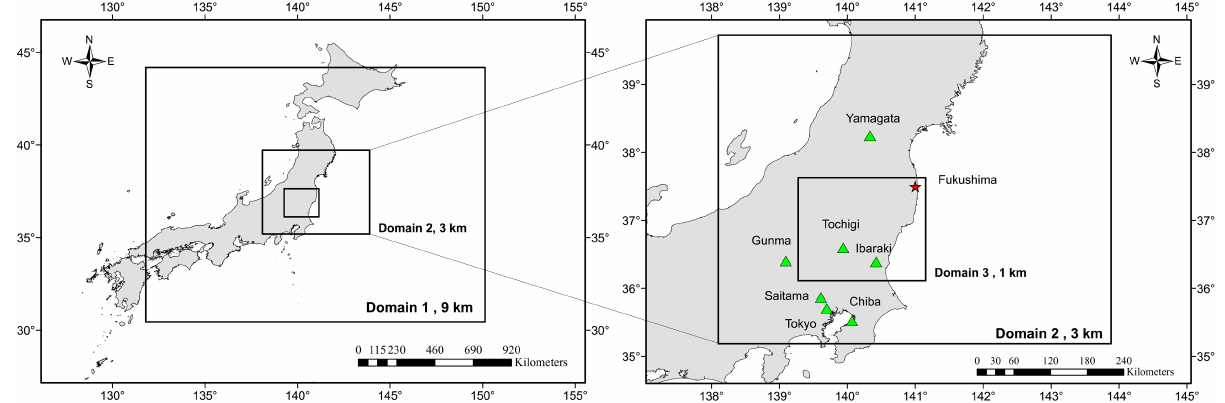
Figure 2. The WRF domain configurations and observational stations. Left: domain 1, 2 and 3. Right: domain 2 and 3. The red star on the right panel represents FDNPP (source of radioactive release) and the green triangles represent observational stations where deposition of radionuclides was measured (other stations are used for evaluation of the meteorological outputs of WRF). Table 1. Description of WRF simulations. In the column for wet deposition, “precipitation” is short for the parameterization based on precipitation and “RH” is short for the parameterization based on relative